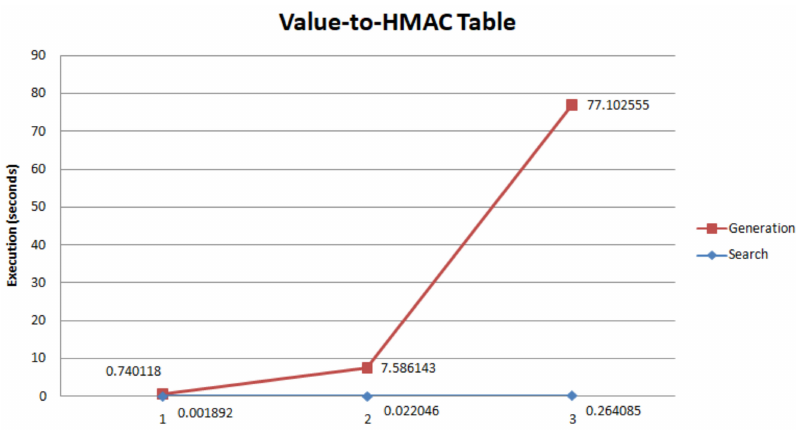
Figure 5. Timings of HMAC table generation and search